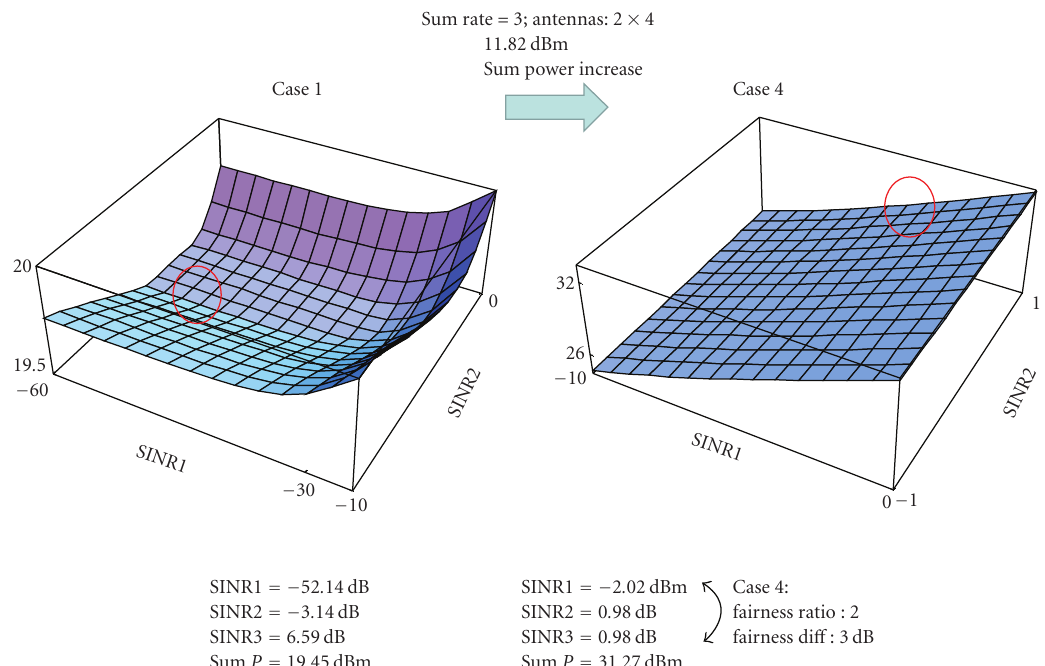
Figure 8: Power consumption without precoding in Case 1 and in Case 4. In Case 4, the lowest SINR must be at least half of the highest SINR MS. The point that satisfies this (and the capacity) constraint and minimizes the sum power is indicated on the right-hand side figure. With this constraint, the sum power is much higher than in the unconstraint case. Realistically, this fairness case is not feasible due to typical individual power limitations (24dBm).